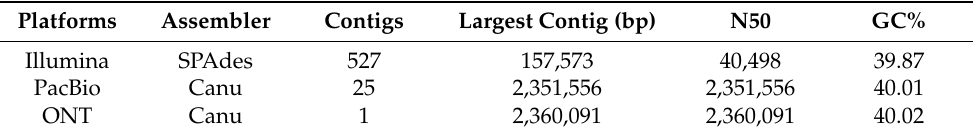
Table 1. Statistics of genome-assembly results of independent assembly